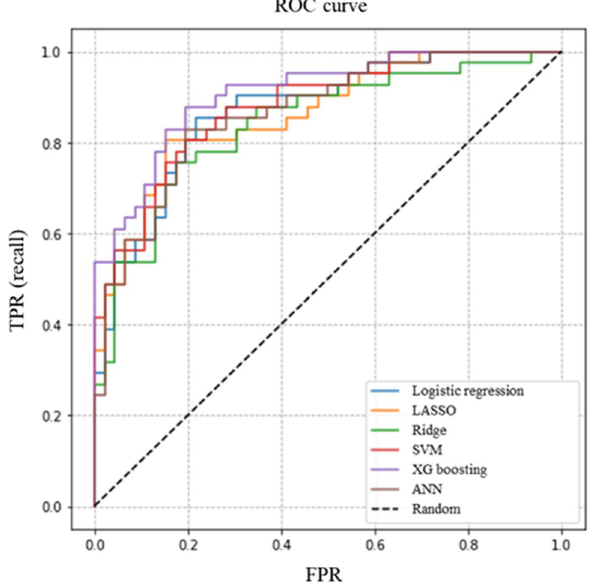
Figure 1. The AUC of each algorithm shown using colored lines. The image was drawn in Python 3.6. AUC area under the curve, ROC receiver operating characteristic, TPR true positive rate, LASSO least absolute shrinkage and selection operator regression, SVM support vector machine, ANN artificial neutral